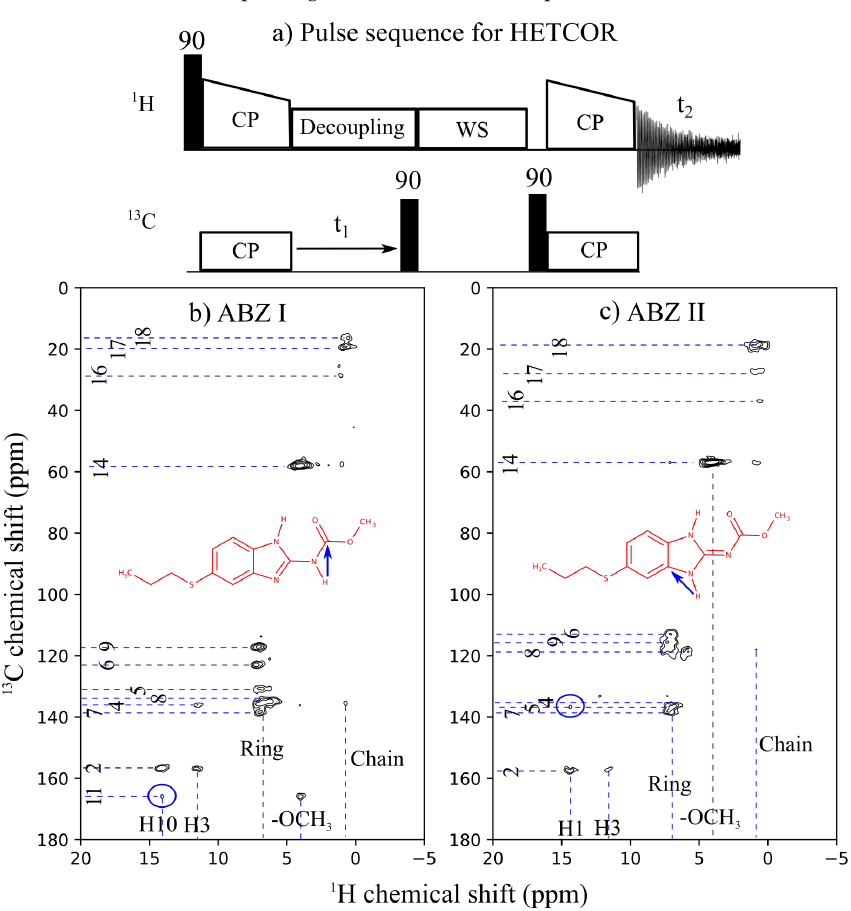
Figure 5. ( a ) Pulse sequence for proton detected HETCOR experiment. HETCOR spectra of: ( b ) ABZ I; and ( c ) ABZ II. Forward CP is from 1 H to 13 C and the reverse CP is from 13 C to 1 H , WS stands for water suppression in the pulse sequence and was achieved with MISSISSIPPI [31]. The spectra were recorded at a field of 11.7 T with the MAS spinning of 57.143 kHz at a temperature of 320